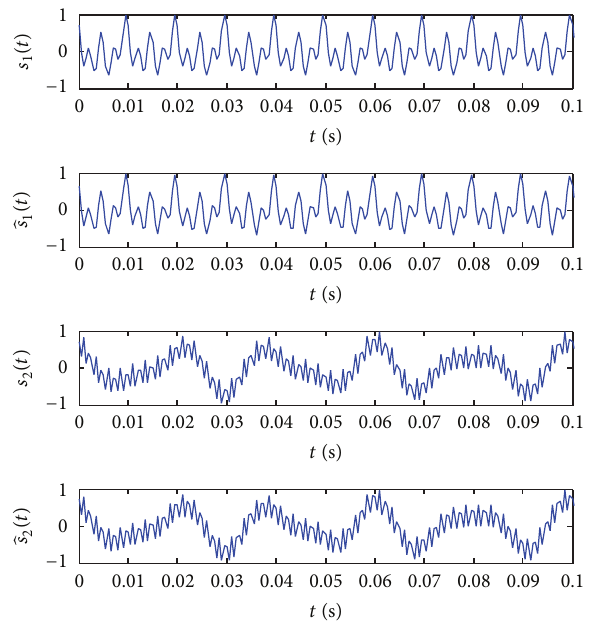
Figure 1: Numerical results of fast-ICA ( 𝐿 = 400